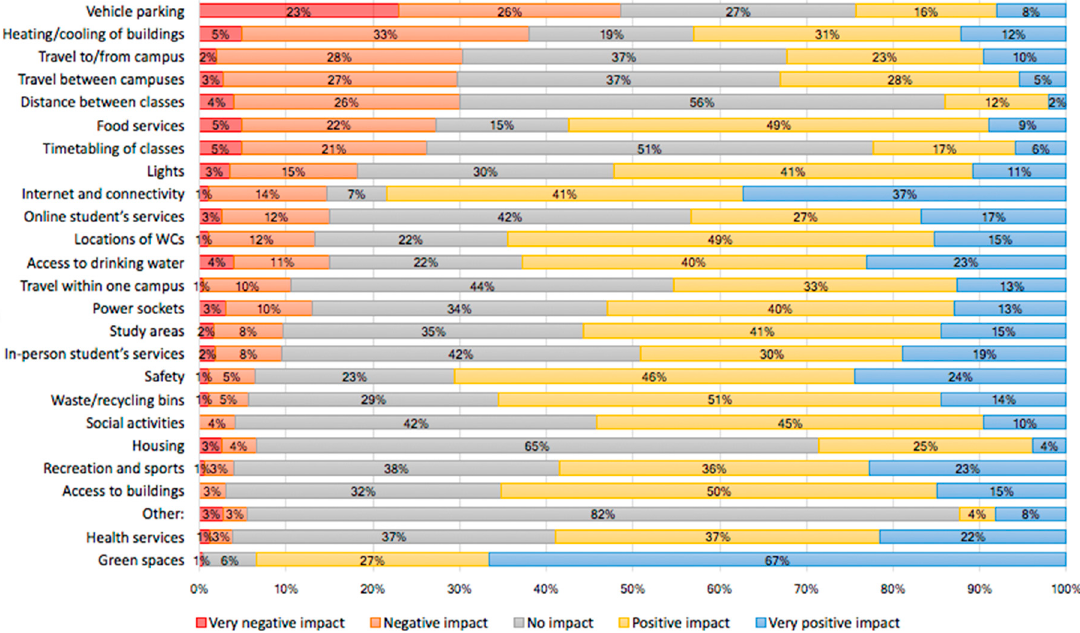
Figure 2. Rating by survey participants on how much each of the listed aspects impacts positively or negatively on their daily experience of the campus (sorted on ‘very negative’ and ‘negative’ impacts combined).